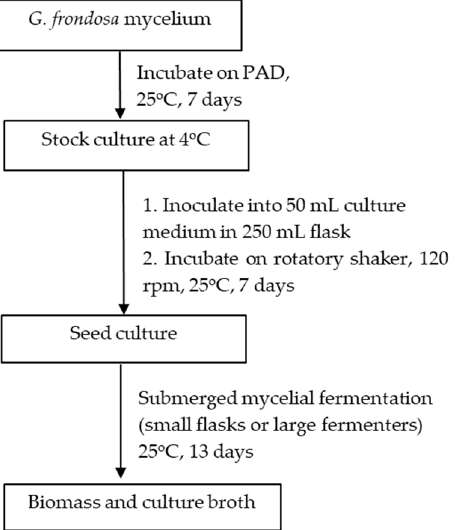
Figure 2. Submerged culture fermentation of the G. frondosa mycelium adapted from [4] .